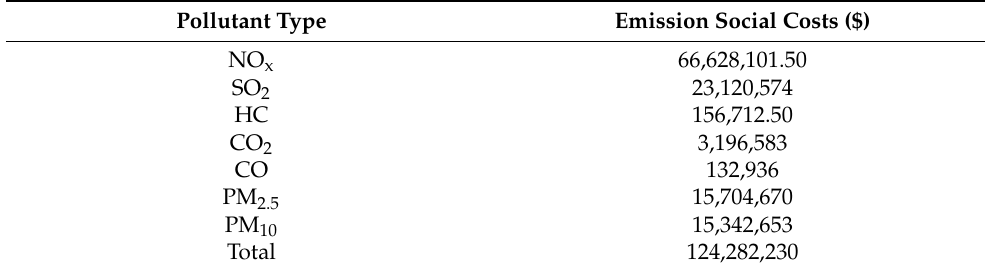
Table 6. Ship emission social